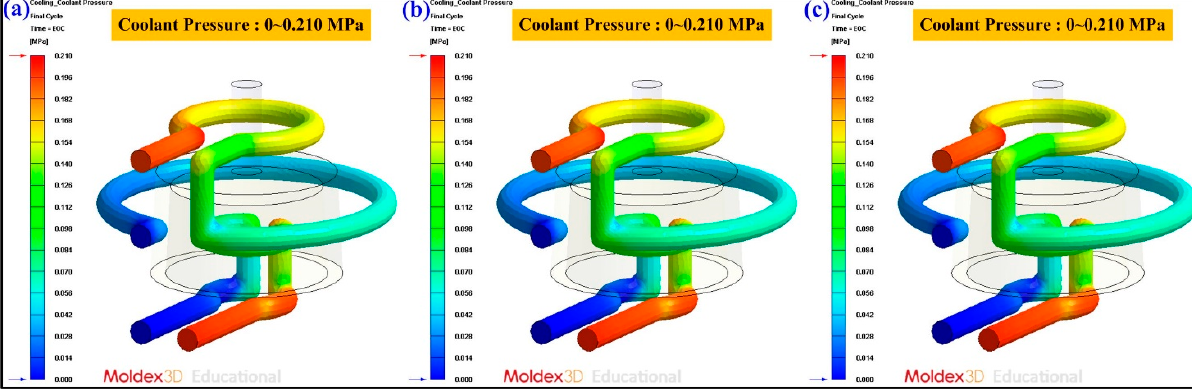
Figure 16. Numerical simulation results of the coolant pressure difference for ( a ) conventional SRM, ( b ) SRM with 60 wt.% Al powder, and ( c ) SRM made with recipe 4.